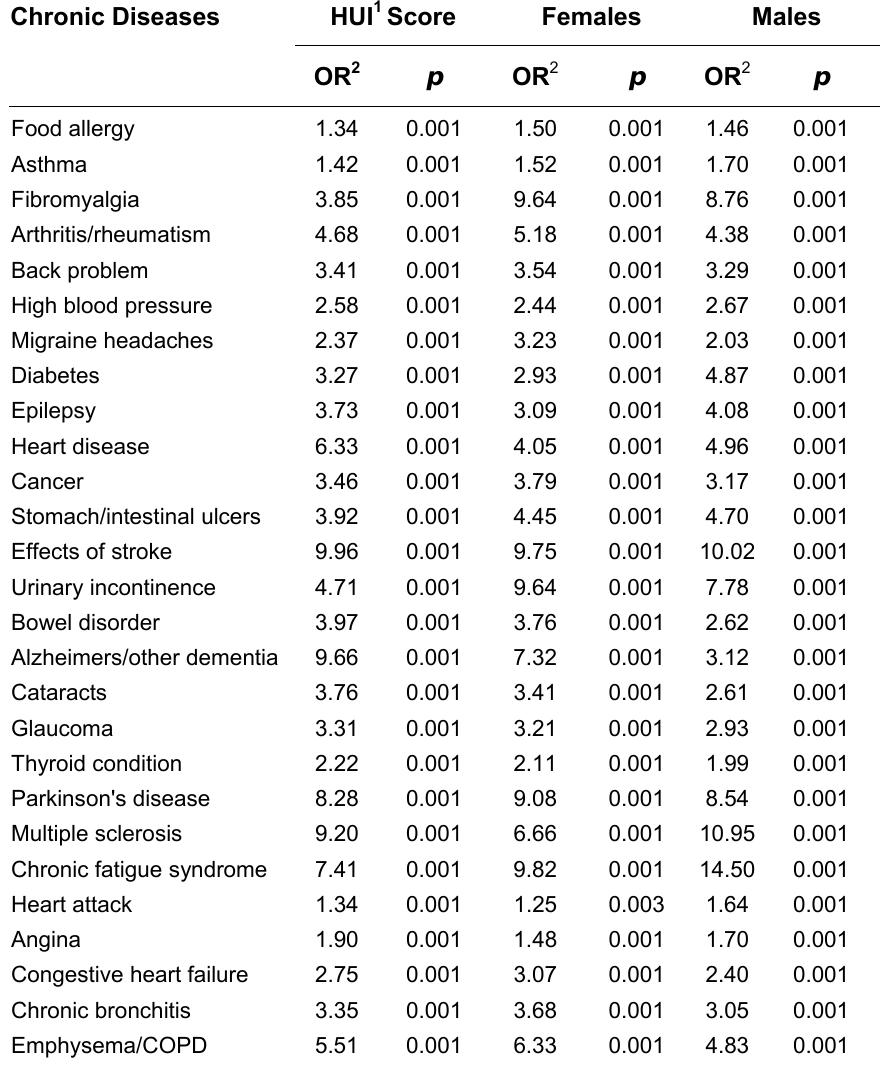
Adjusted OR for HUI ≤ 0.5 and p Values from Logistic Regression Model Between HUI Scores and the Selected Chronic Conditions by Gender Chronic